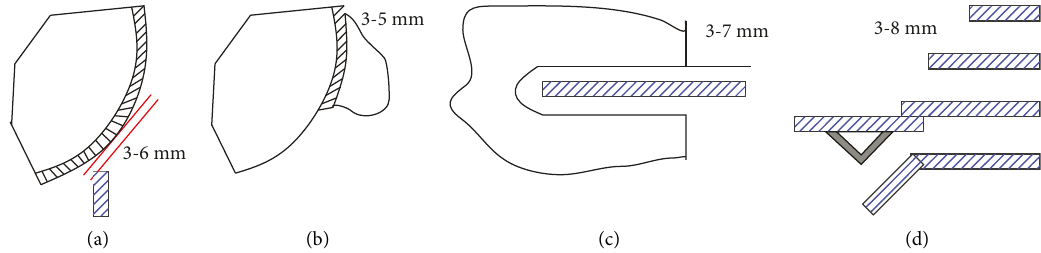
Figure 4: Schematic diagram of the positional relationship between the comb plate and the conveying roller: (a) clearance between the conveying roller and the vertical plate, (b) clearance between the delivery roller and the transverse comb plate, (c) space between the transport roller flange and the comb-tooth plate groove, and (d) clearance between the transport roller flange and the middle separator.